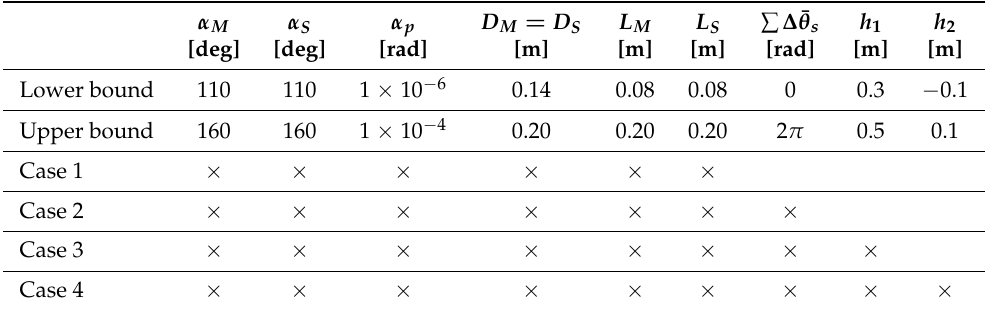
Table 5. Tunable parameters along with their lower and upper bounds, noting which parameters are optimized in which co-design